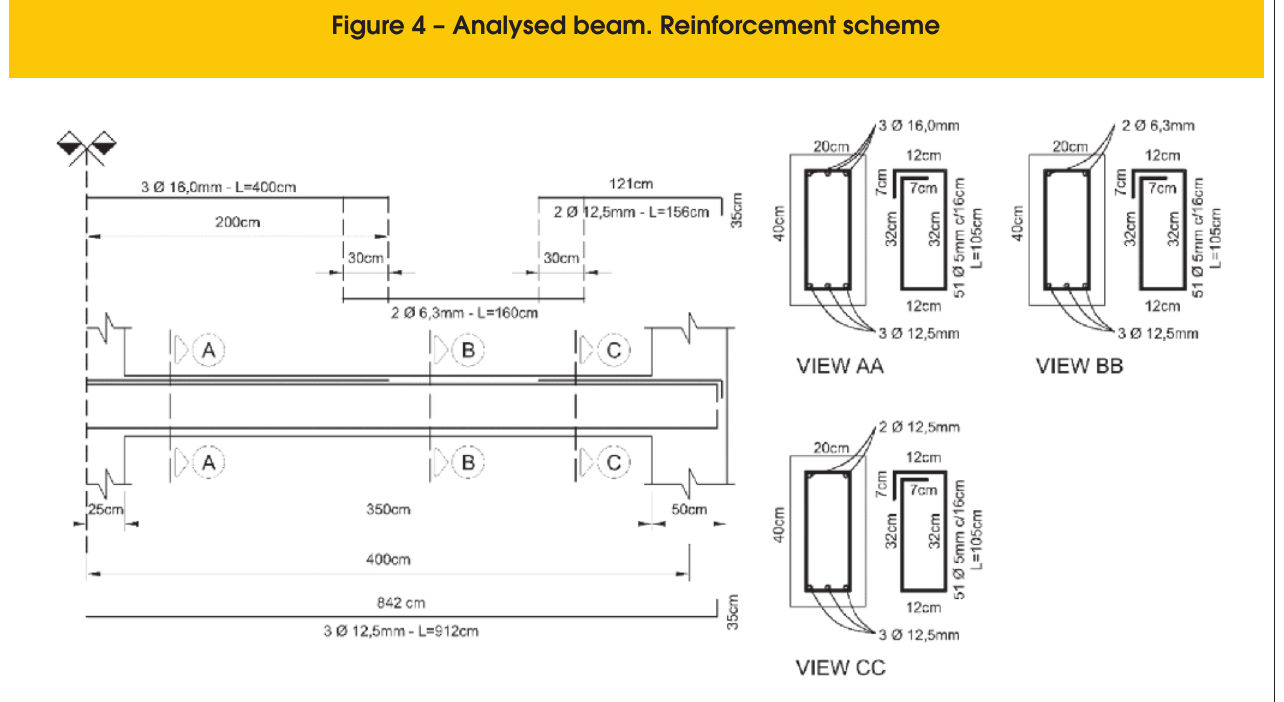
Figure 4 – Analysed beam. Reinforcement